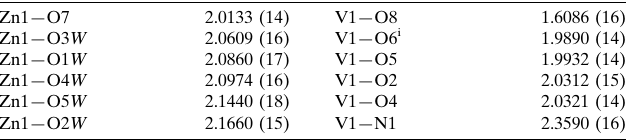
Selected bond lengths (A˚ ).